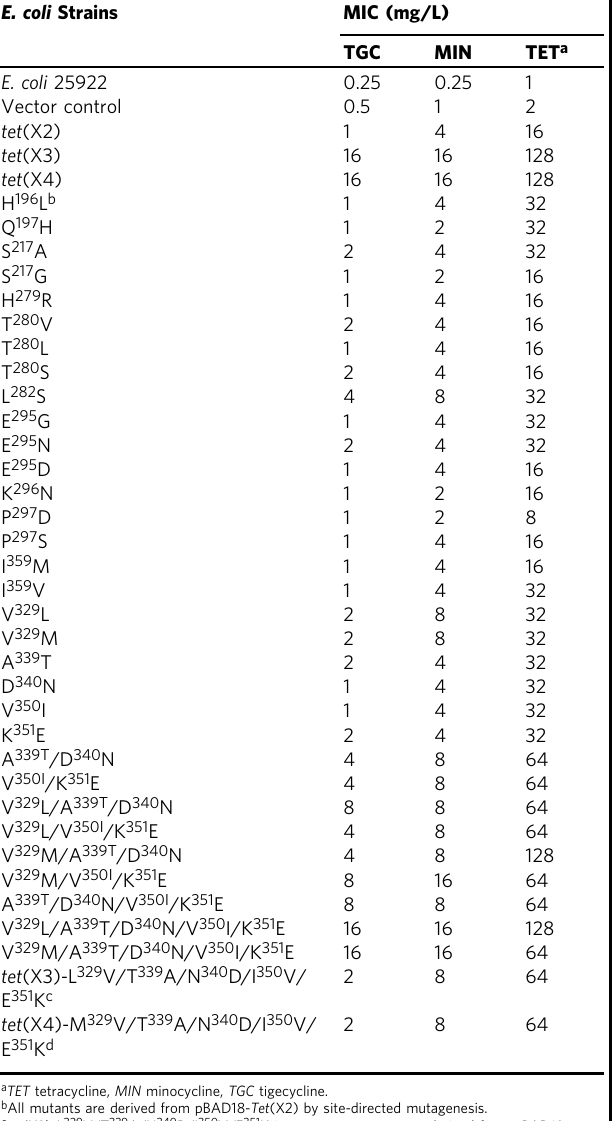
Table 1 MICs for E. coli BW25113 strains harboring a pBAD18 plasmid which contains a tet (X2), tet (X3), tet (X4), mutated tet (X2) gene, mutated tet (X3) gene or mutated tet (X4) gene.